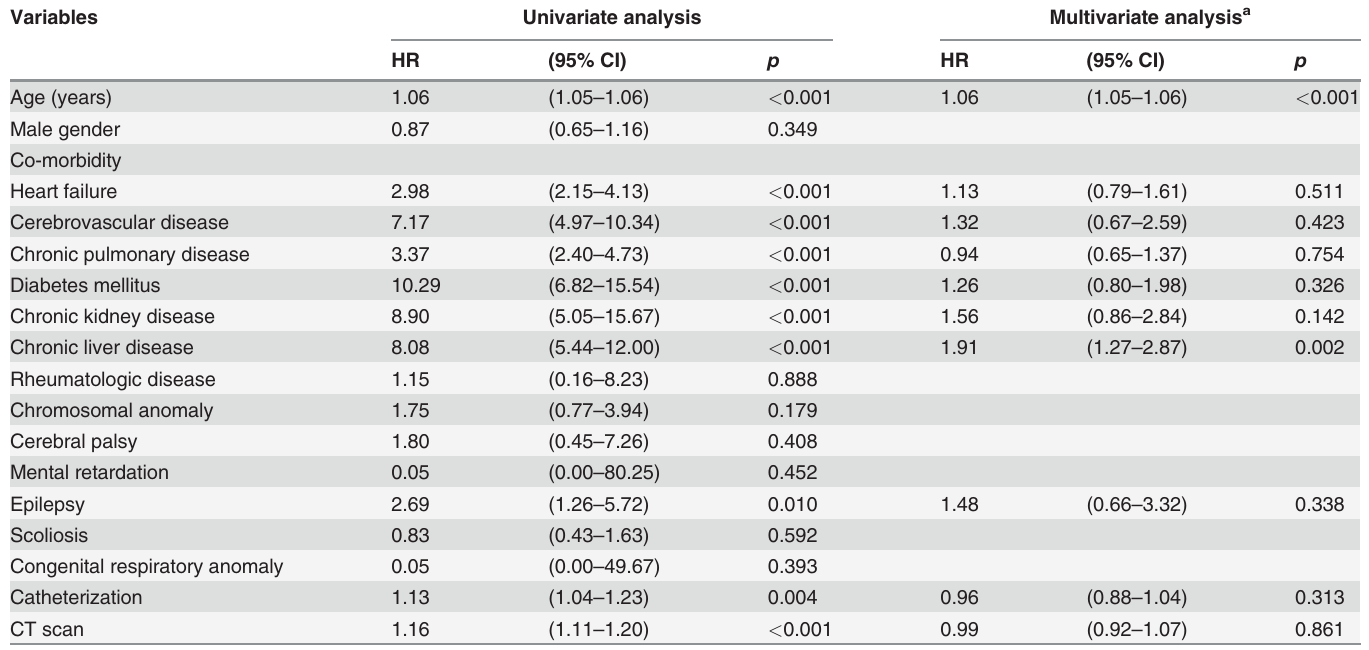
Table 5. Hazard ratio (HR) for risk factors of cancer among patients with